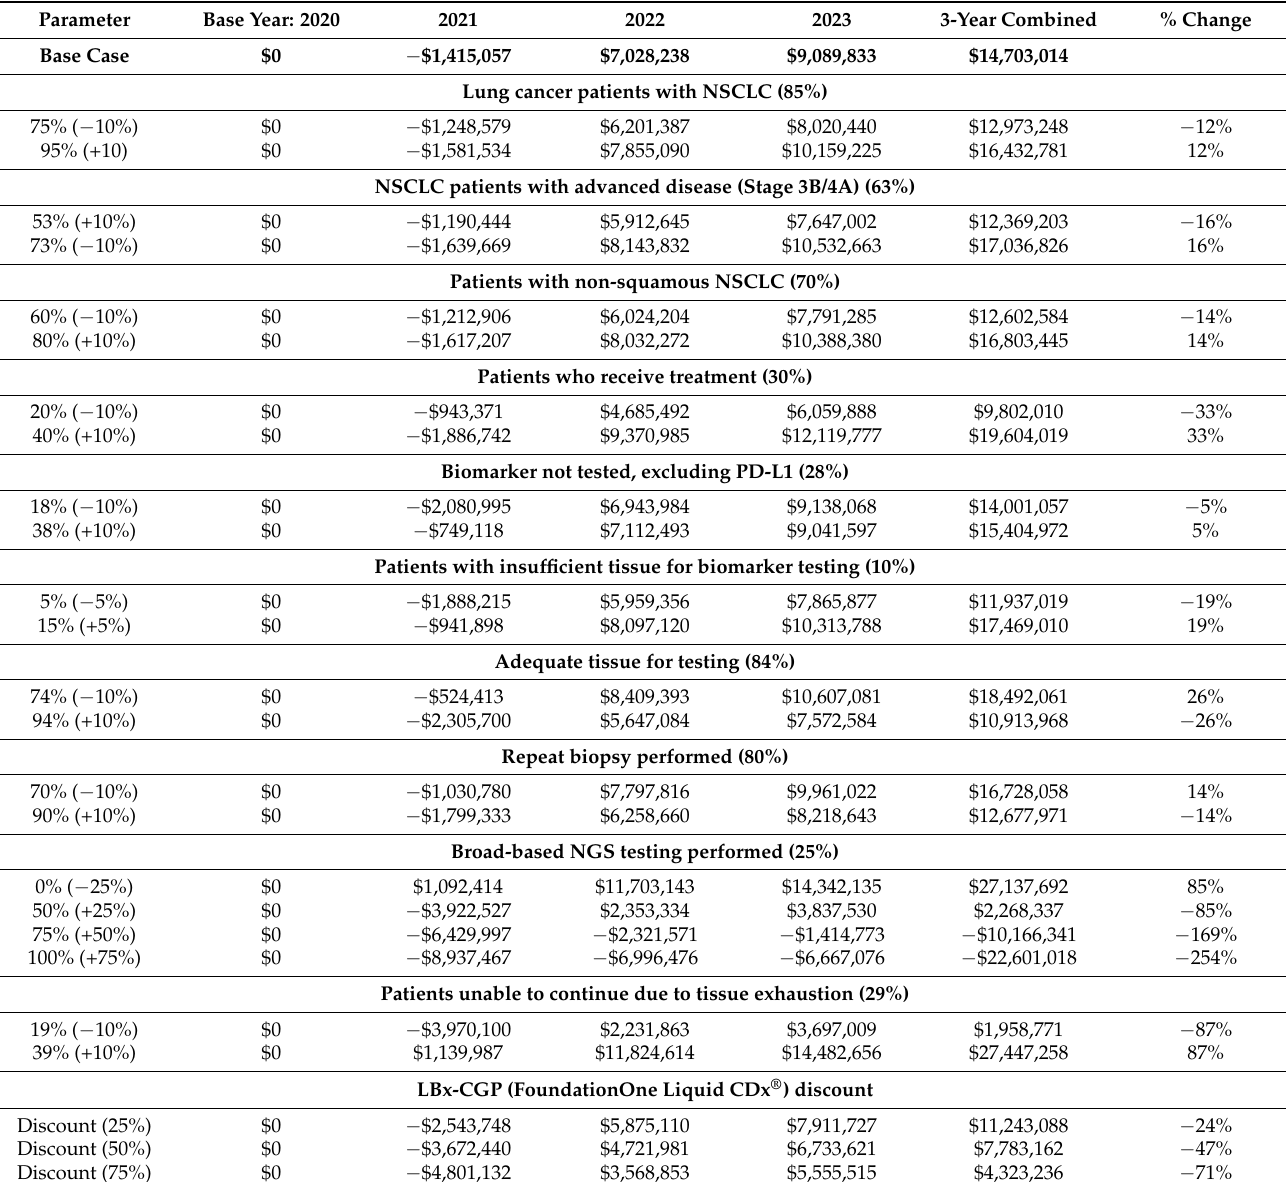
Table A2. One-way sensitivity analysis